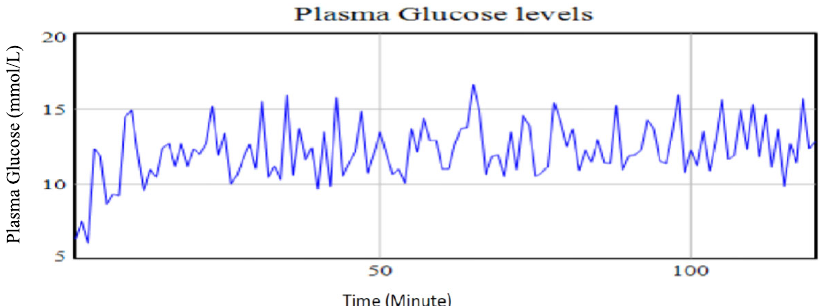
Figure 12. Plasma glucose levels using identified parameters for the extended Bergman Minimal Model for a type II diabetic patient with an increase of 66.67% in the amount of carbohydrates is taken with an increase in stress levels by 233.33% while holding physical exercise intensity at the base run